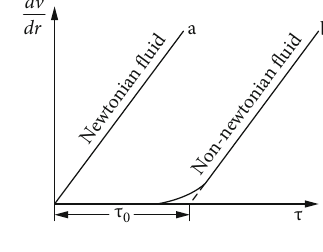
Figure 3: Rheological curve of grout.